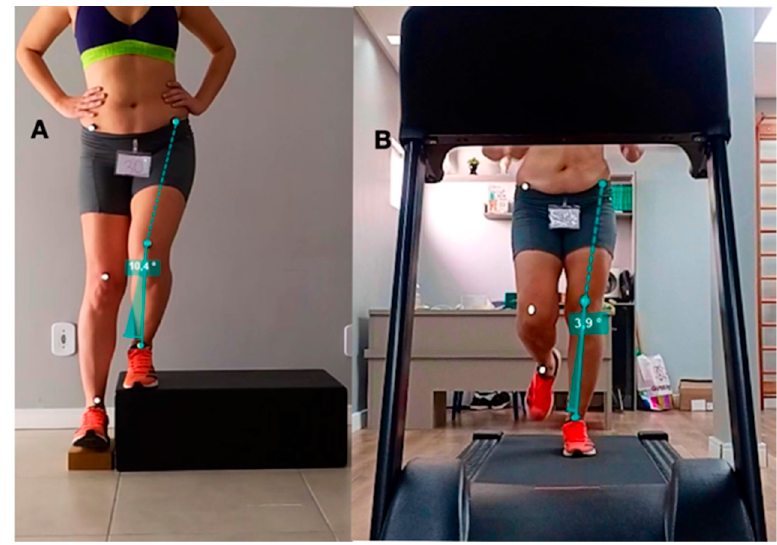
Figure 2. Frontal plane knee projection angle (FPPA) measured during lateral step down ( A ) and running ( B ).